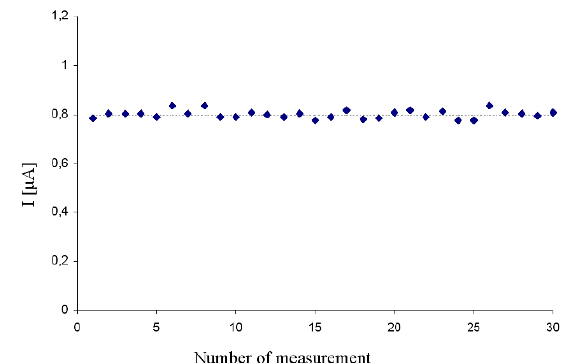
Figure 5. Operational stability of ADH/TiO2/MB/MWCNT/Nafion biosensor measured in 0.3 mmol/L ethanol solution, dotted line – mean value of first three measurements; supporting electrolyte: phosphate buffer solution, pH 8.0; E = -50 mV vs. app.